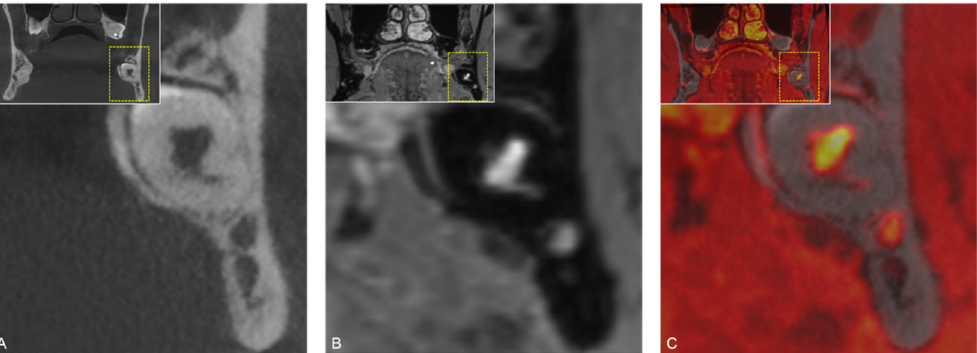
Figure 7. ( A ) CBCT, ( B ) MRI, and ( C ) fused CBCT/MRI scans of the positional relationship between the mandibular canal (MC)/inferior alveolar nerve (IAN) and the mandibular third molar (MTM). This borderline case visualizes the advantages of the selected imaging modality and their respective limitations. Additional relevant information, whether direct visualization of the IAN is possible or only the bony borders of the MC can be displayed, is presented depending on the imaging modality.